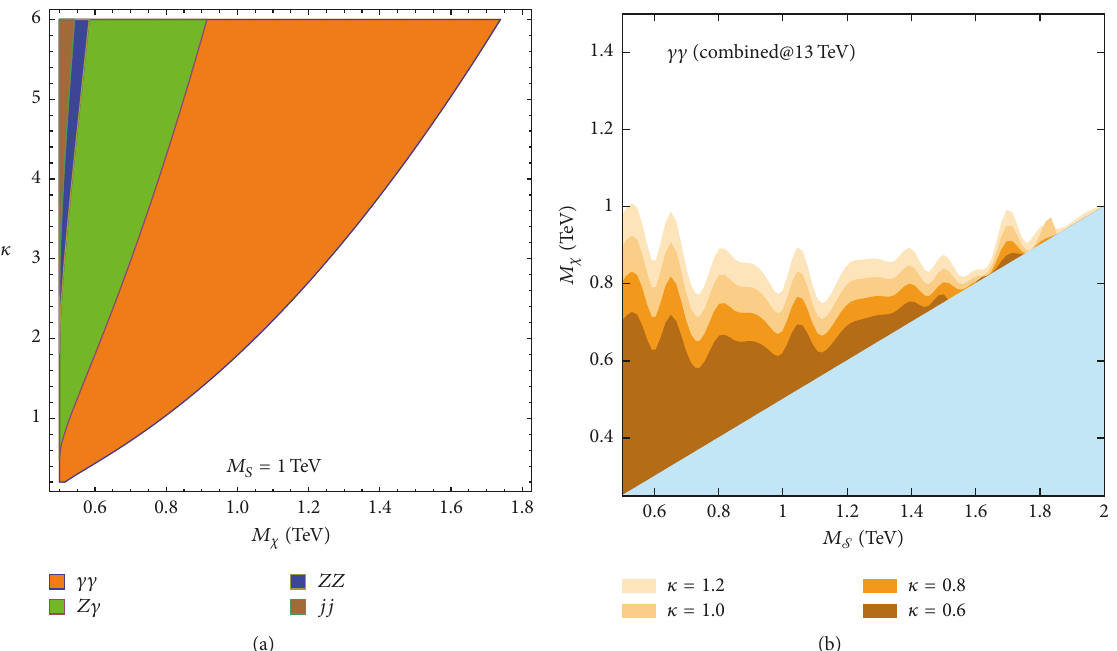
Figure 4: (a) The excluded region in 𝑀 𝜒 - 𝜅 plane for 𝑀 S = 1 TeV from the 13TeV LHC data. The orange, green, blue, and brown regions represent the region ruled out by the 𝛾𝛾 , 𝑍𝛾 , 𝑍𝑍 , and 𝑗𝑗 resonance search data, respectively. (b) The excluded region in 𝑀 S - 𝑀 𝜒 plane for different 𝜅 with Λ = 5 TeV using the 13TeV combined ATLAS and CMS diphoton resonance search. ATLAS and CMS data are combined statistically using (25). The widths of the resonance assumed by ATLAS and CMS are 4 MeV [62] and 140 MeV [63]. The sky-blue region cannot be probed in our analysis as we assume 𝑀 𝜒 > 𝑀 S /2